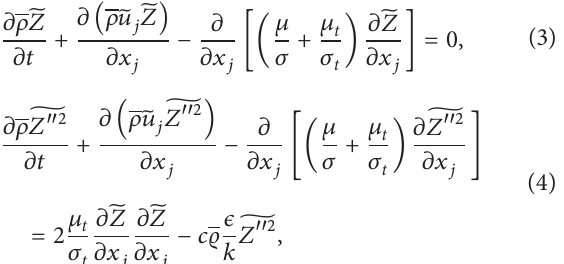
along the S-shaped curve (Figure